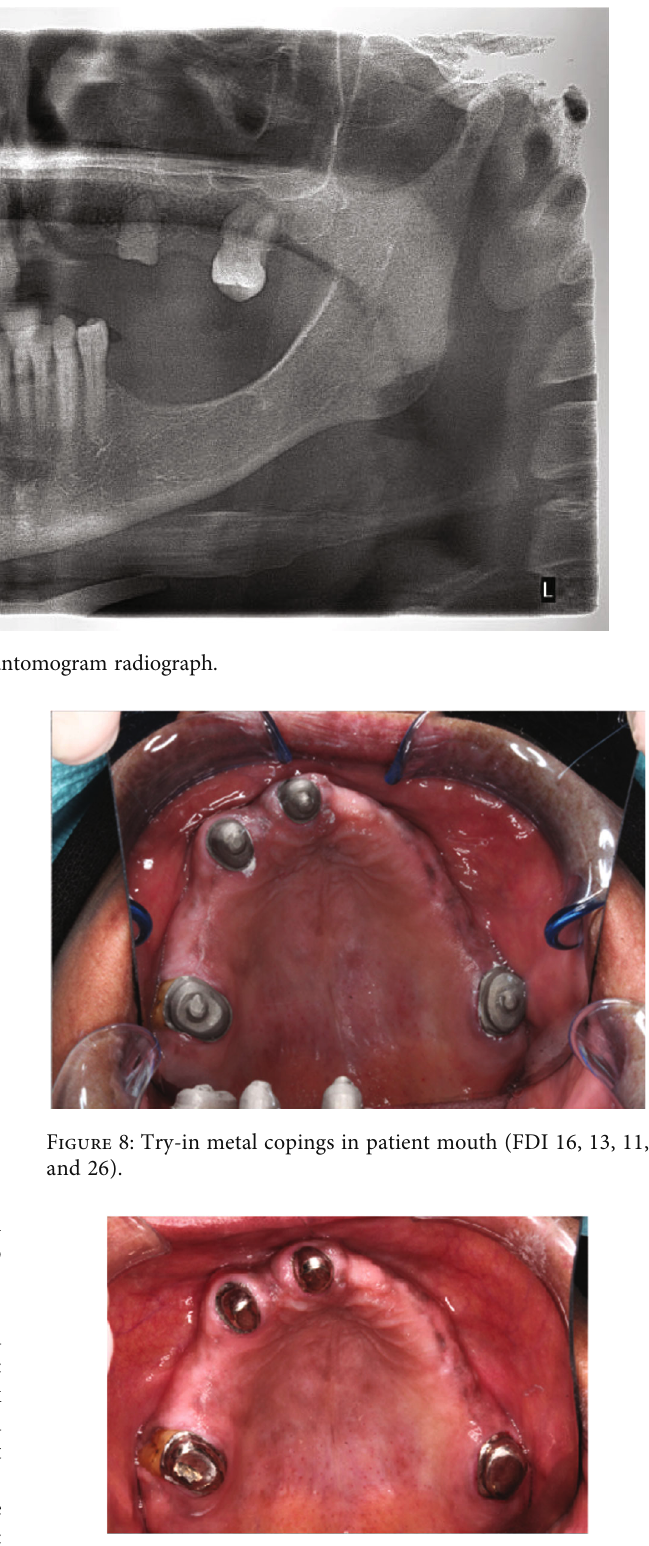
Figure 9: Finished and polished primary metal coping in patient